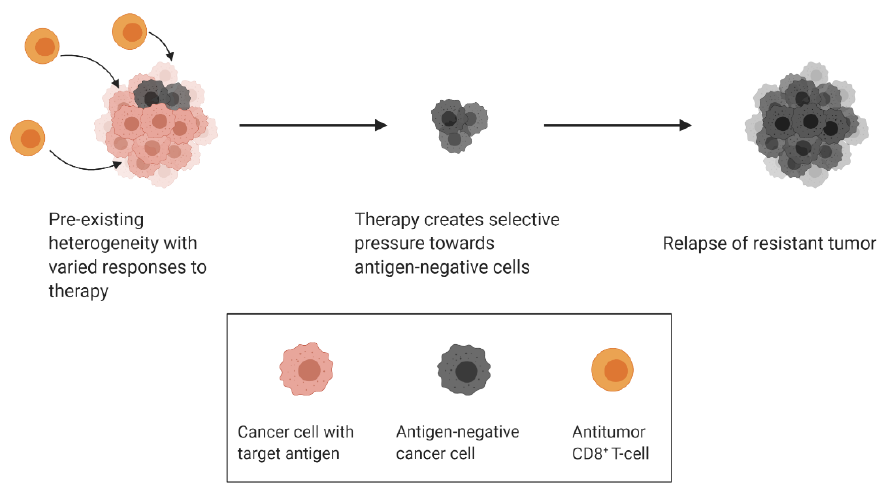
Figure 3. Selective pressure from antitumour T-cells drives resurgence of antigen-negative clones.